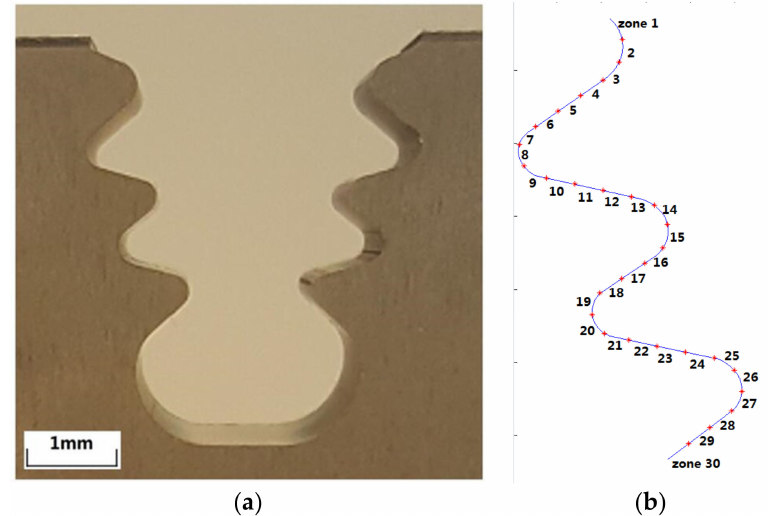
Figure 8. ( a ) Geometry of the generic fir-tree slot for industrial tests; ( b ) The profile is divided into 30 zones in which CMM measurements are compared with clustering results. Table 6. Hierarchical clustering using T d distribution of the 30 zones in which the fir-tree profile was divided for the